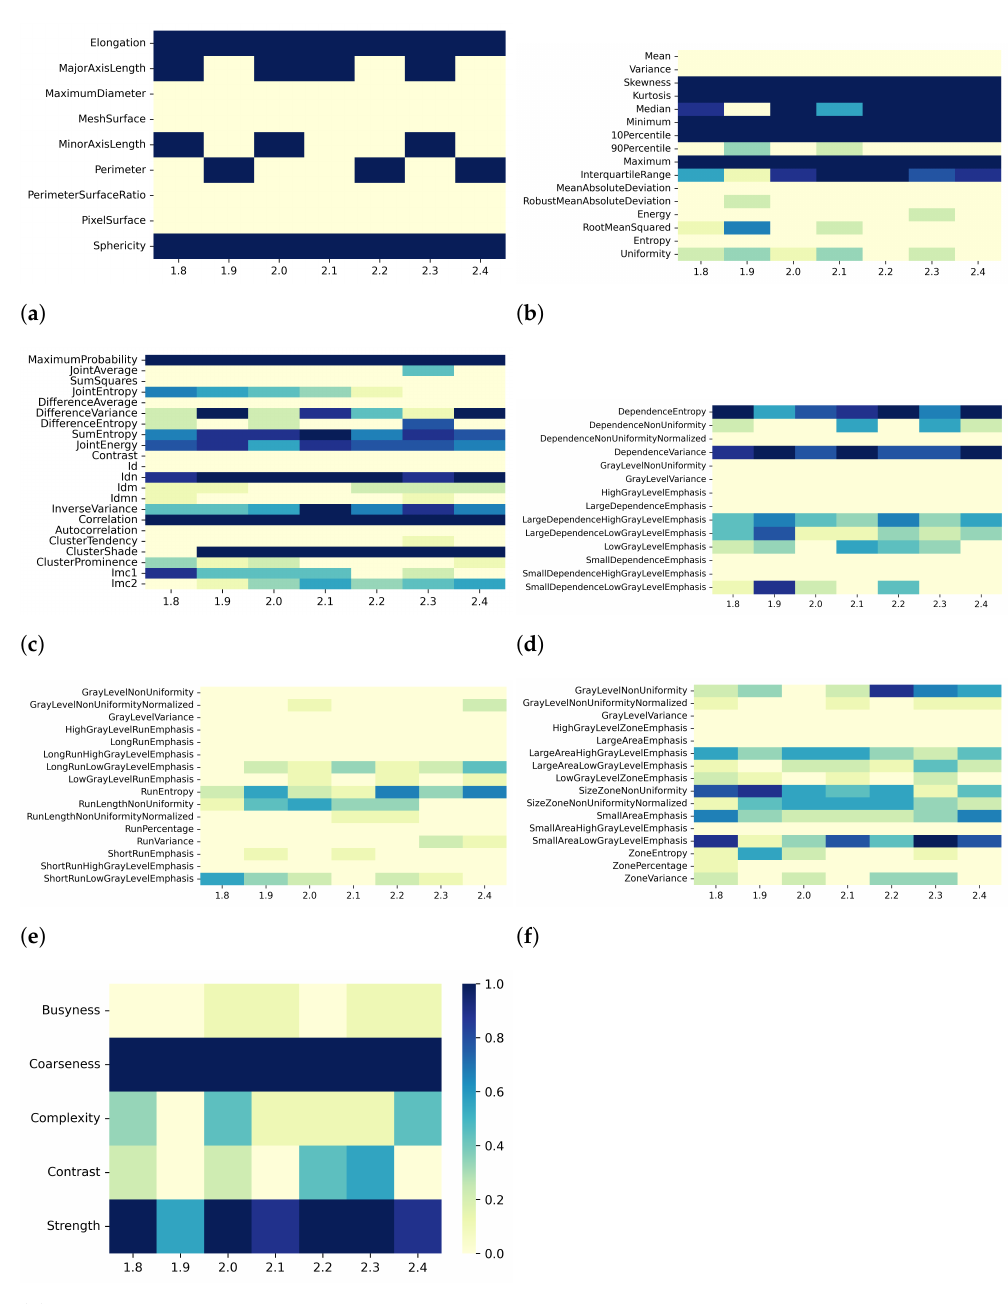
Figure 5. Heatmaps of remaining features from T1 maps after SCC-based dimensionality reduction for effect B (varying discretization bin width, with fixed resampling voxel size (mm)). The radiomic features are separated in classes: ( a ) 2D shape, ( b ) first order, ( c ) GLCM, ( d ) GLDM, ( e ) GLRLM, ( f ) GLSZM, ( g )